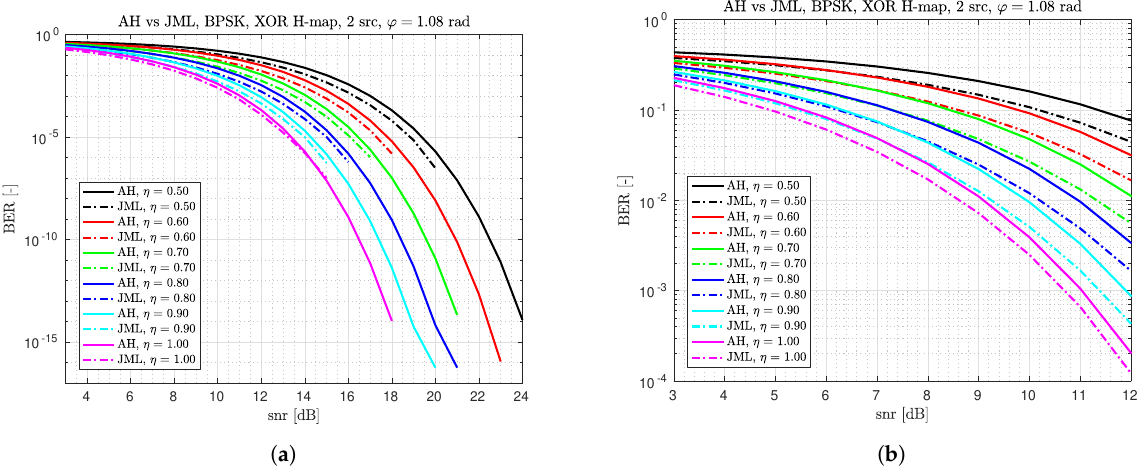
Figure 4. H-BER of ad hoc (AH) vs. JML detector for different ranges of SNR. ( a ) Ad hoc (AH) vs. JML detector for SNR from 3 dB to 24 dB. ( b ) Ad hoc (AH) vs. JML detector for SNR from 3 dB to 12